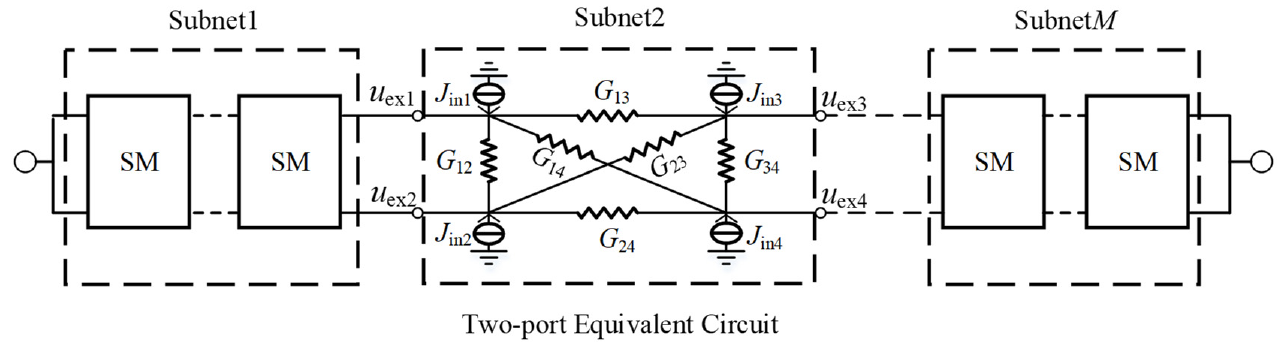
Figure 4. Topology of MMC based on P ‐ FBSM.